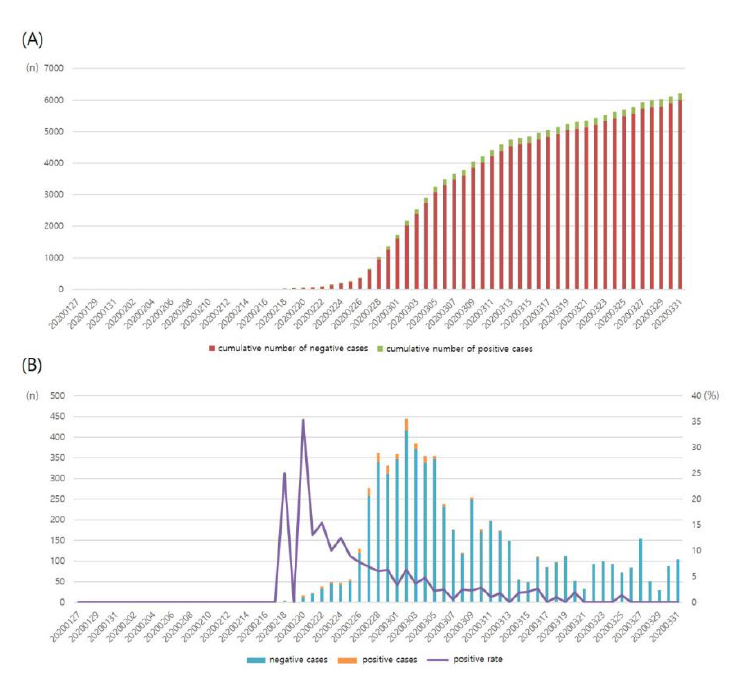
Figure 3. ( A ) Graph showing the cumulative number of positive and negative cases after SARS-CoV-2 testing and positive test result rate by date in the screening clinic of our university hospital. ( B ) Graph showing the daily number of positive and negative cases after SARS-CoV-2 testing.